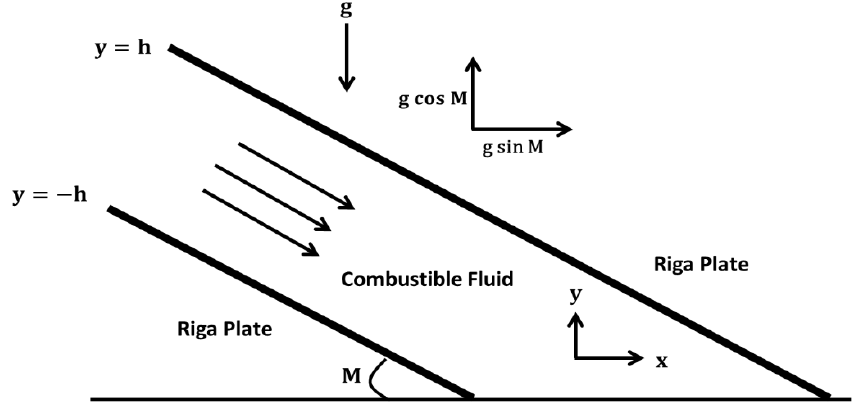
Figure 1. Flow Channel.